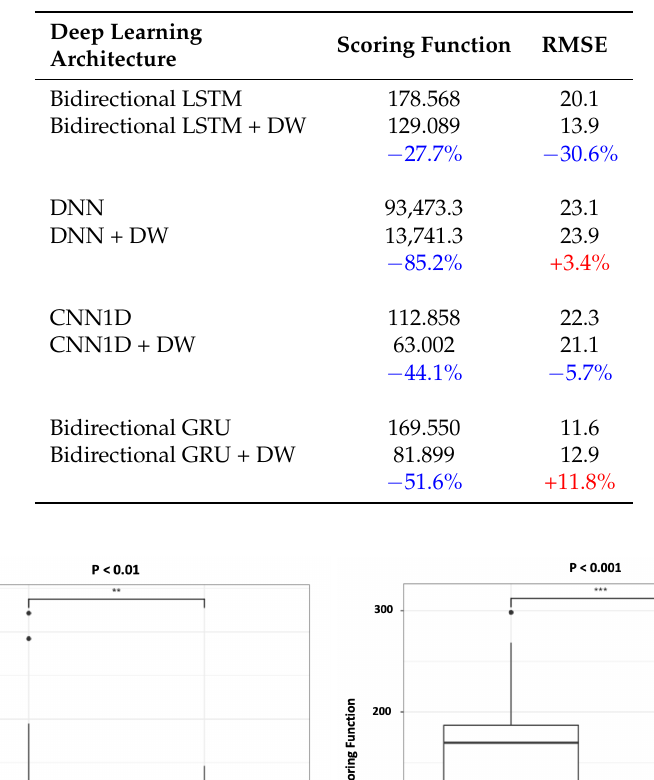
Table 5. Scoring function and root mean squared error (RMSE) before and after using dynamic weighting (DW) for loss function while maintaining the architecture of deep learning models. Blue colored text indicates improved performance while red colored text indicates worsened performance. The values in this table are the median values across 20 experimental runs.